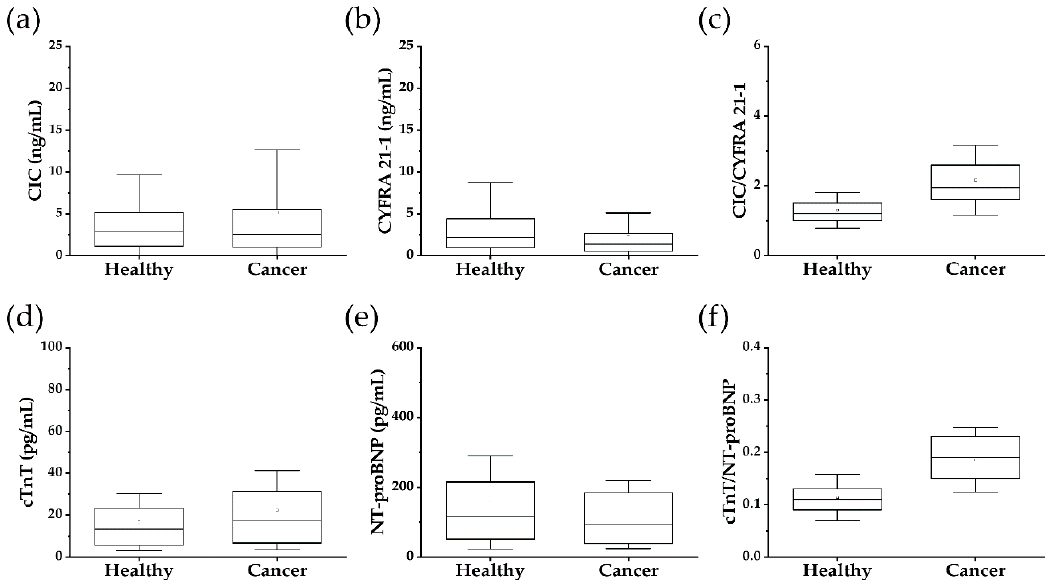
Figure 1. Discrimination of healthy control and lung cancer patients by using ( a ) CIC; ( b ) CYFRA 21-1; ( c ) CIC / CYFRA 21-1 ratio; ( d ) cTnT; ( e ) NT-proBNP; and ( f ) cTnT / NT-proBNP ratio. Healthy control, n = 359; lung cancer samples, n = 224.